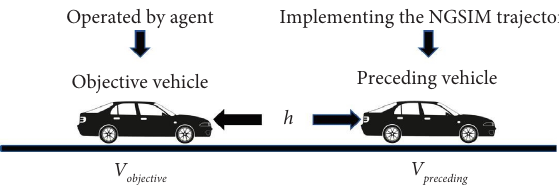
Figure 1: Traditional car following scene in RL environment.